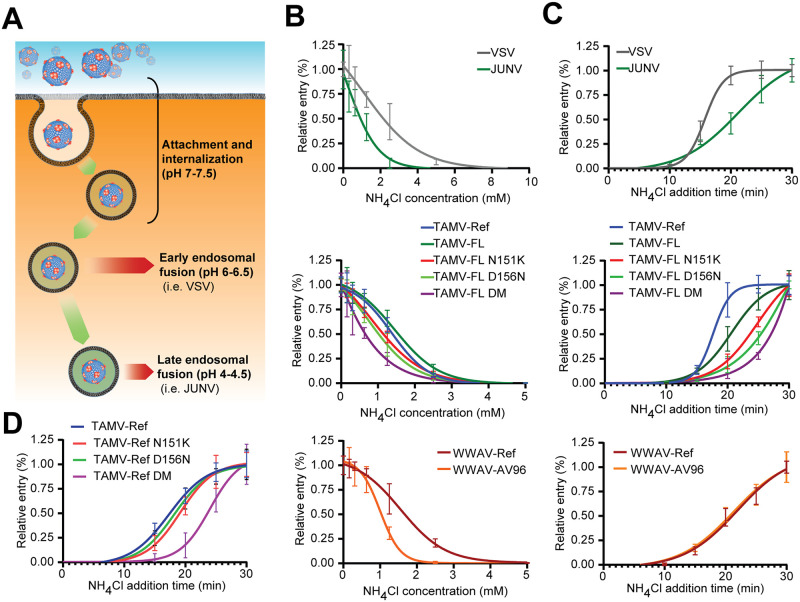
Endosomal escape of clade D NW mammarenavirus.(A) Schematic virus internalization, compartment acidification, and pH-dependent endosomal escape. (B) Ammonium chloride sensitivity of TAMV-FL mutants and WWAV strains. PV infections were performed in presence titrated ammonium chloride concentrations (0–5 mM). Error bars represent standard deviations (n = 6). (C) Endosomal escape of TAMV-FL mutants and WWAV strains. At indicated time points, endosomal exit was prevented with 20 mM of ammonium chloride. Error bars represent standard deviations (n = 3). (D) Endosomal escape of TAMV-Ref mutants. Error bars represent standard deviations (n = 7).